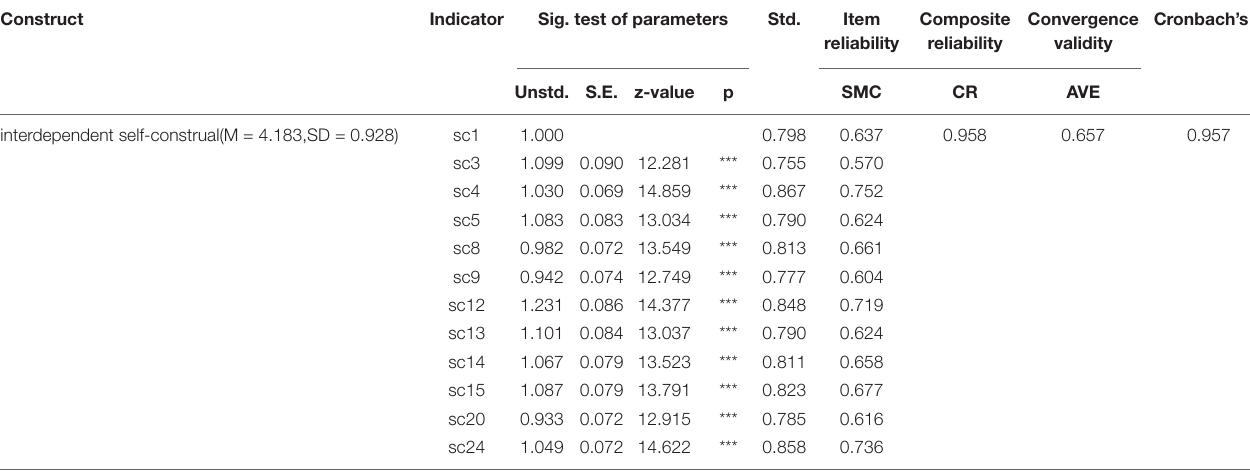
TABLE 2 | Reliability and convergent validity of interdependent self-construal scale ( n = 210). Construct Indicator Sig. test of parameters